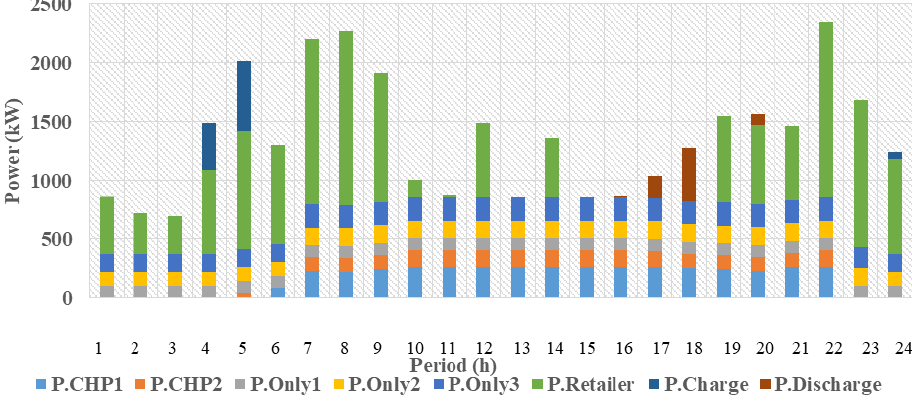
Figure 7. Share of supplying electrical power in a 30% demand response.